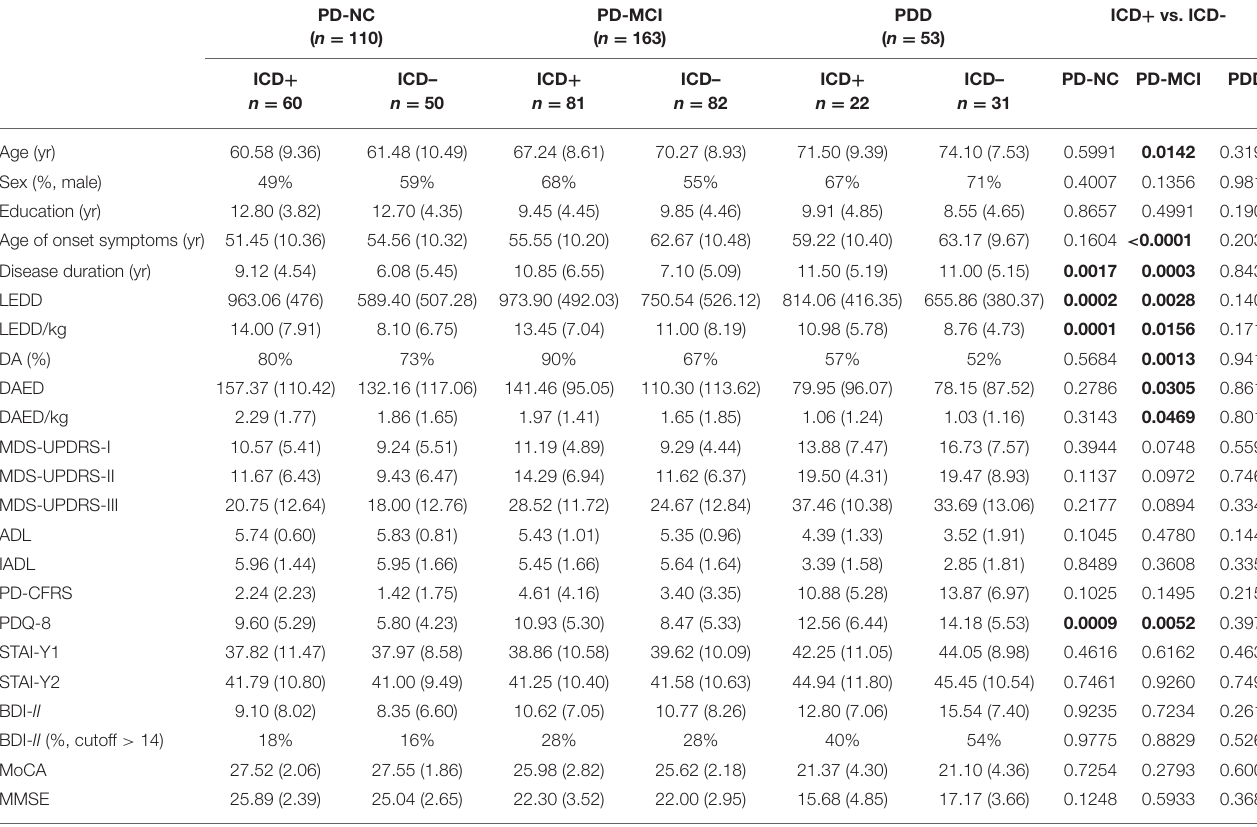
TABLE 1 | Demographic and clinical characteristics of ICD + and ICD– across PD cognitive